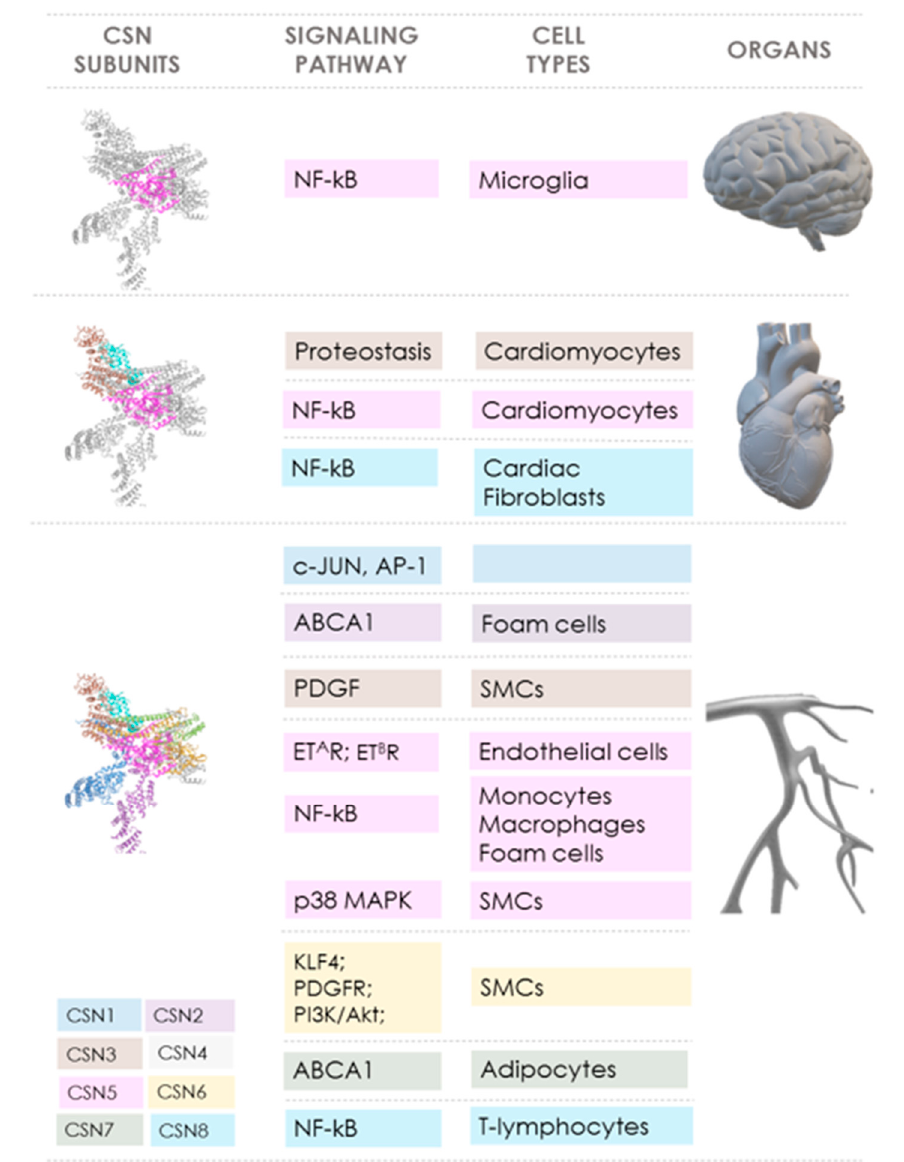
Figure 2. Scheme summarizing the links between COP9 signalosome subunits, signaling pathways, cell types, and organs / tissues in cardiovascular diseases. The cartoon illustrates how CSN (PDB ID: 4D10) subunits CSN1 (dark blue), CSN2 (purple), CSN3 (brown), CSN4 (light gray), CSN5 (pink), CSN6 (yellow), CSN7 (green), and CSN8 (light blue) play a role in cardiovascular diseases. The involved signaling pathways and key regulated proteins as well as the cell types are indicated. The color code of the CSN subunits corresponds to that of the respective signaling pathway and cell type, and is sorted by a ff ected organ (brain (top), heart (middle), and vasculature (bottom)). Details are described in the main manuscript text. Abbreviations: ABCA1, ATP-binding cassette transporter (member 1 of human transporter sub-family ABCA). Akt, protein kinase B. AP-1, activator protein-1. CSN, constitutive photomorphogenesis (COP) 9 signalosome. ET A R, endothelin receptor type A. ET B R, endothelin receptor type B. MAPK, mitogen-activated protein kinase. NF- κ B, nuclear factor kappa-light-chain-enhancer of activated B cells. PDGF, platelet-derived growth factor. KLF4, Krüppel-like factor 4. PDGFR, platelet-derived growth factor receptor. PI3K, phosphatidylinositol 3-kinase. SMCs, smooth muscle cells. Organ images were produced with Microsoft Power Point 2019.